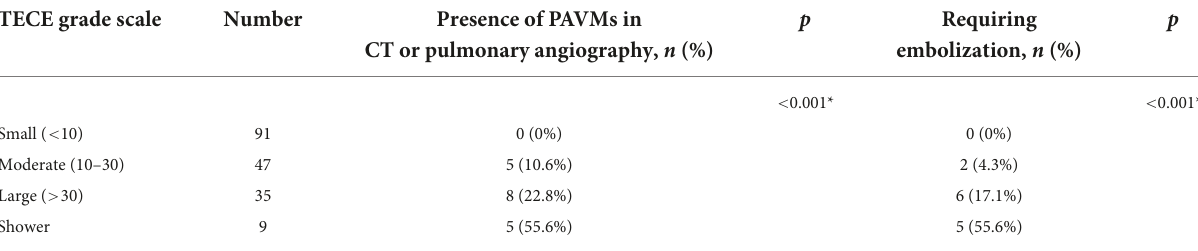
TABLE 4 Relationship between the TECE grade scale and the presence of PAVMs in CT or pulmonary angiography and PAVMs that required